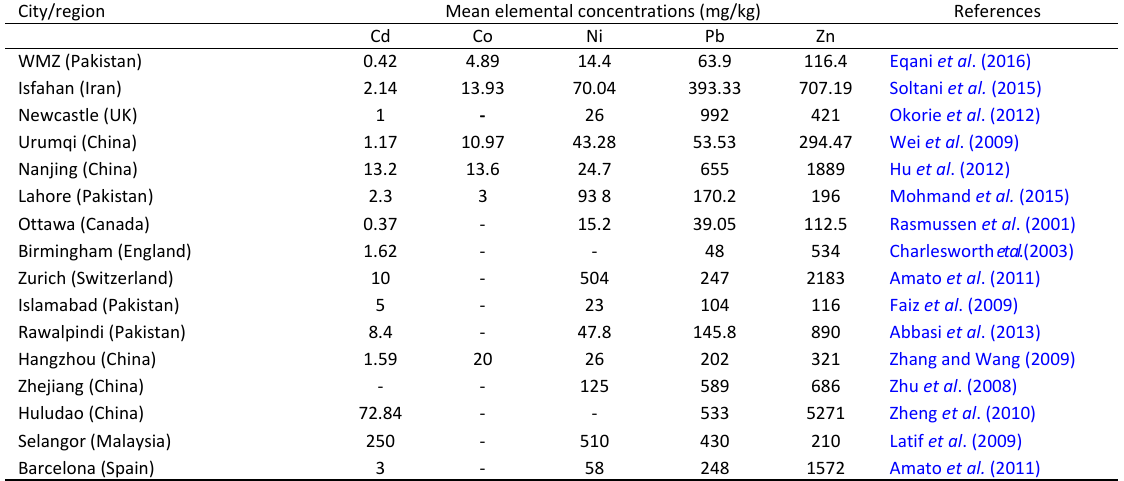
Table 3: Analysis of variance (mean square) of Fraxinus excelsior L. Table 3. Analysis of variance (mean square) of Fraxinus excelsior L.